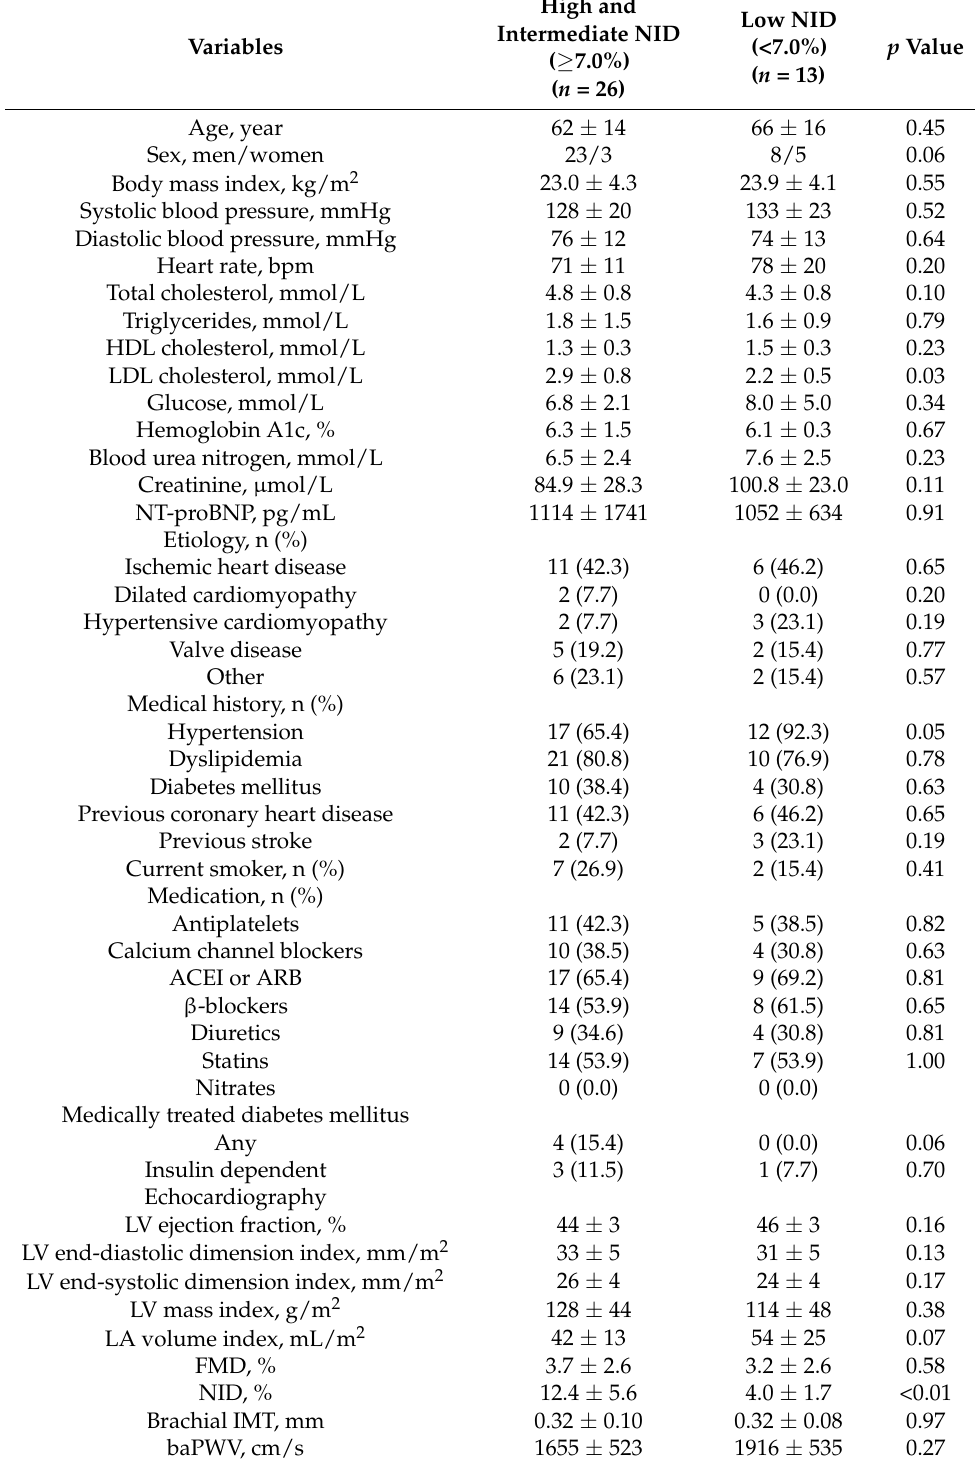
Table 3. Clinical characteristics of the patients with HFmrEF in follow-up